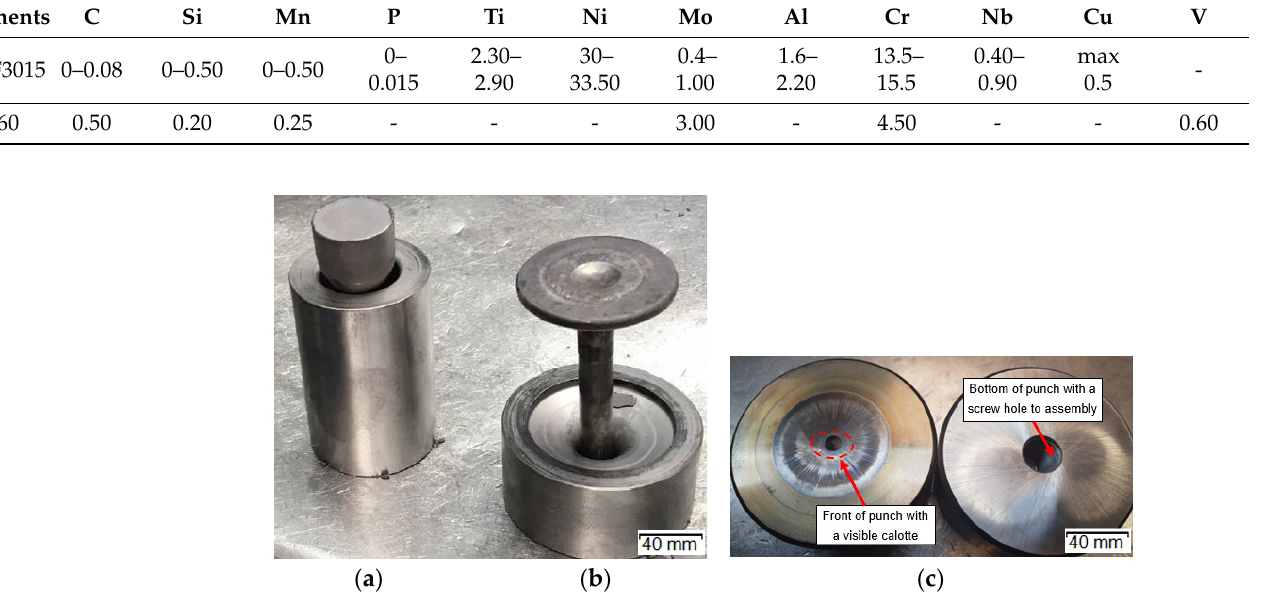
Table 1. The chemical composition of the input material (NCF3015) and tools (W360) [%].